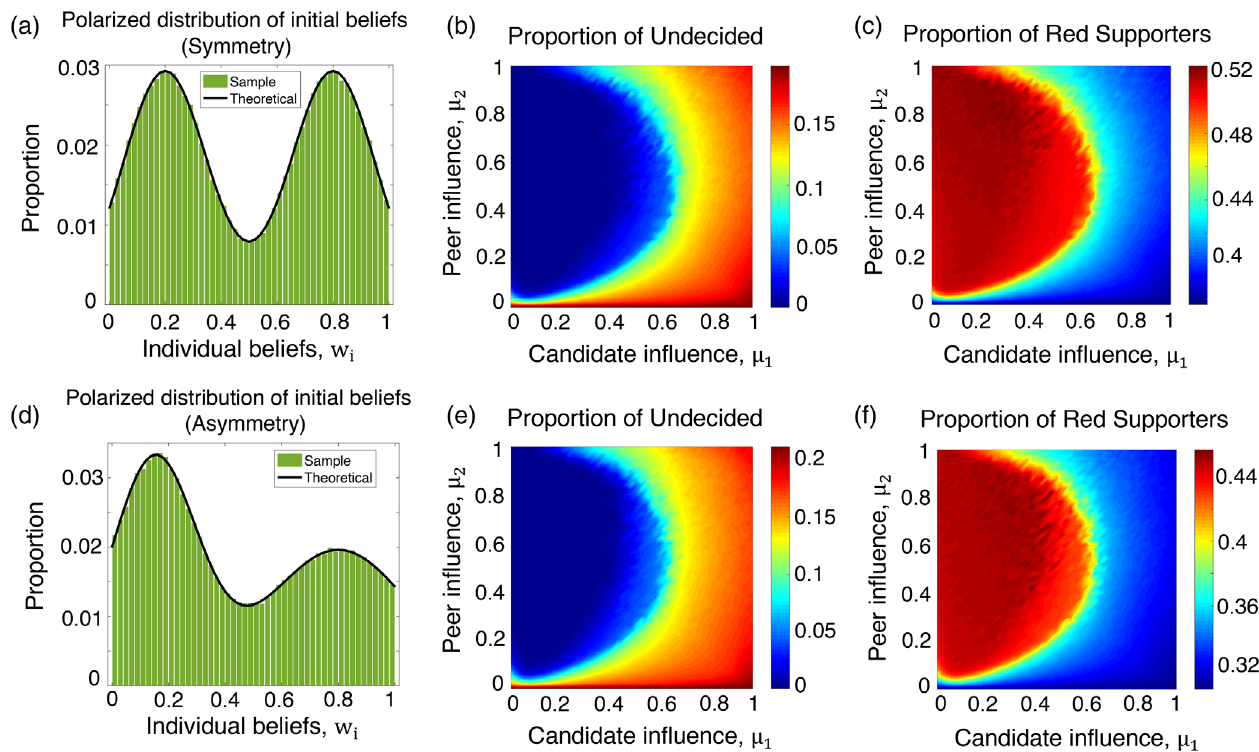
FIG. 11. Candidate influence and peer influence under polarized initial beliefs. We relax the initial condition of individual beliefs from uniform distribution to (a) – (c) symmetrical bimodal distribution and (d) – (f) asymmetrical bimodal distribution. Simulation results are averaged over 30 independent runs. Parameters: All simulations begin from an ER graph with N ¼ 10 4 , h k i ¼ 6 , Ω T ¼ 0 . 5 , θ 1 ¼ 0 . 2 , θ 0 . 7 , and δ 0 . 18 2 ¼ 1 ¼